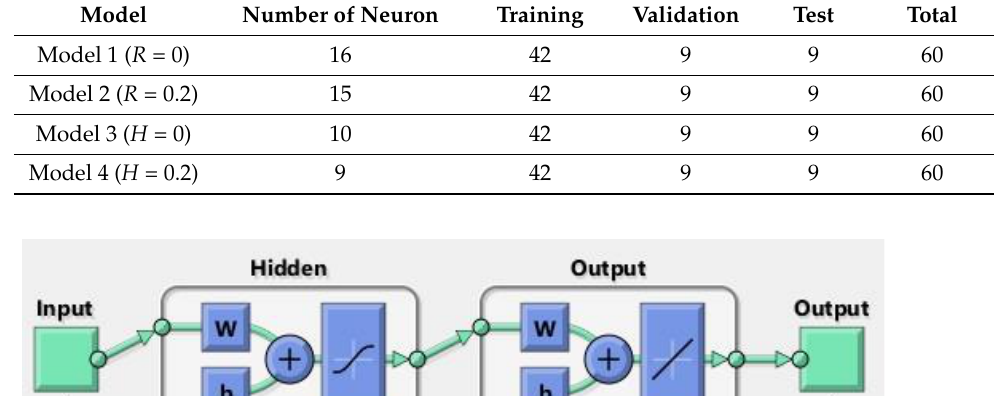
Table 14. Information about the data set used in each ANN model and the number of neurons.